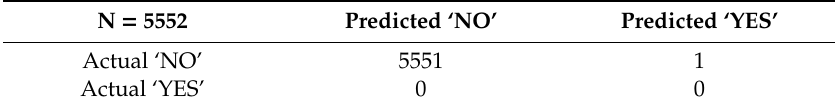
Table 4. Confusion matrix for real-world